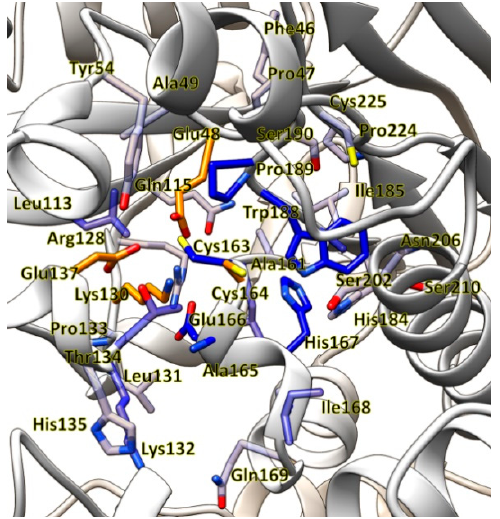
Figure 3. Model for the active centre of the nitrilase from P. fluorescens EBC191.